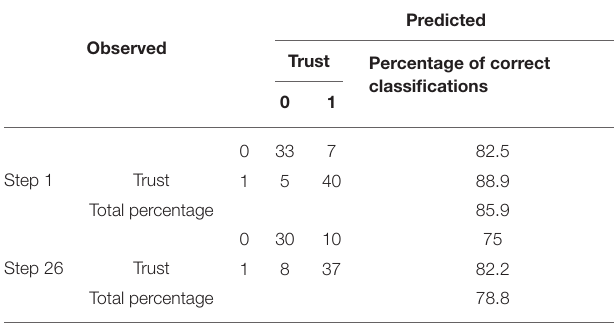
TABLE 7 | Percentage of correct classifications in the training data for the dependent variable “trust.”